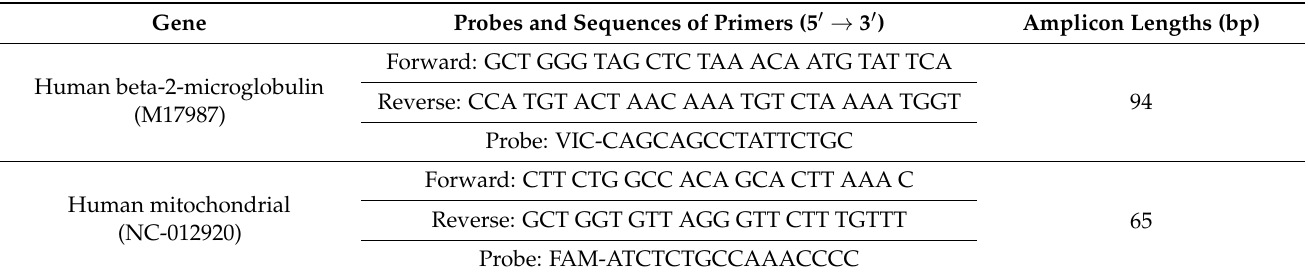
Table 1. Probes and primer sequences of multiplex quantitative PCR